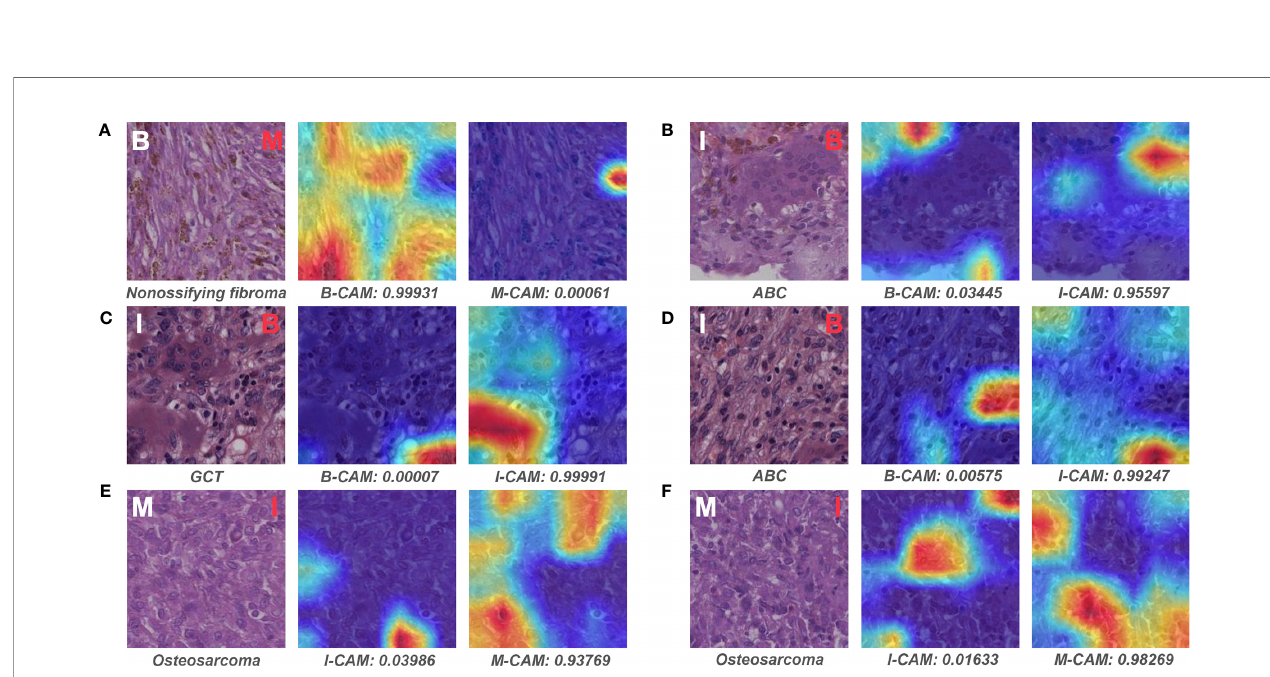
FIGURE 9 | Representative patches of slides wrongly classi fi ed by pathologist #1 and the associated Grad-CAM results. The ground truth label of the original patch is displayed on the upper left in white, and the predictive classi fi cation of pathologist #1 is presented on the upper right in red (false prediction). The speci fi c classi fi cation is shown under the original patch, and the predictive probability for CAM of each class is shown below the corresponding Grad-CAM heatmap. (A – F) show the representative patches of benign, intermediate, and malignant bone tumors, respectively. B, benign; I, intermediate; M, malignant; CAM, class activation mapping; ABC, aneurysmal bone cyst; GCT, giant cell